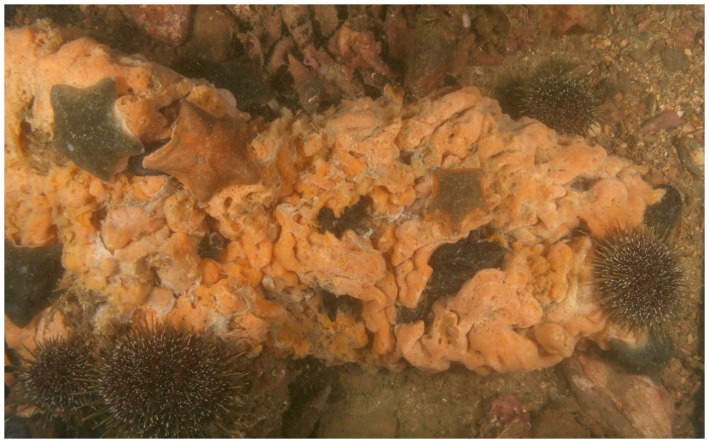
Predation on Didemnum following transplant to the seabed.Image shows predation by cushion stars, Patiriella regularis, and sea urchins, Evechinus chloroticus, on a large (∼20×35 cm) fragment of Didemnum. Predation by these and/or other species was observed following fragment inoculation into beds of the macroalga Carpophyllum flexuosum, and when settlement plates with fragments or pre-established Didemnum colonies were placed on the seabed.